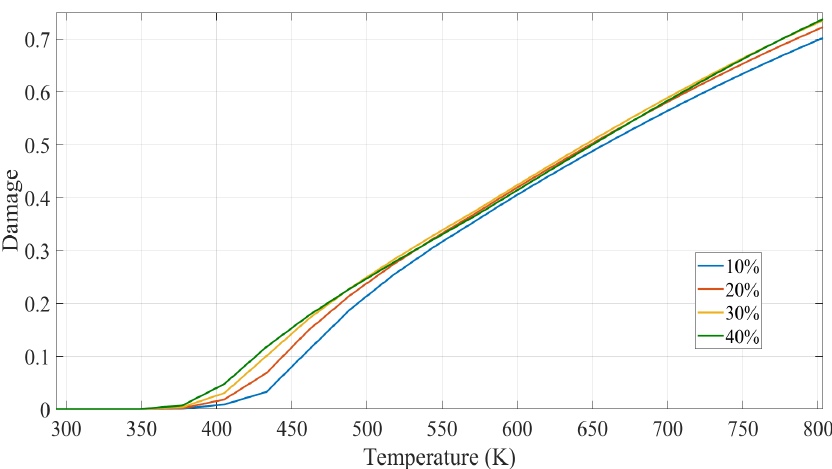
Figure 16. Damage x Temperature relation for concretes with different aggregates